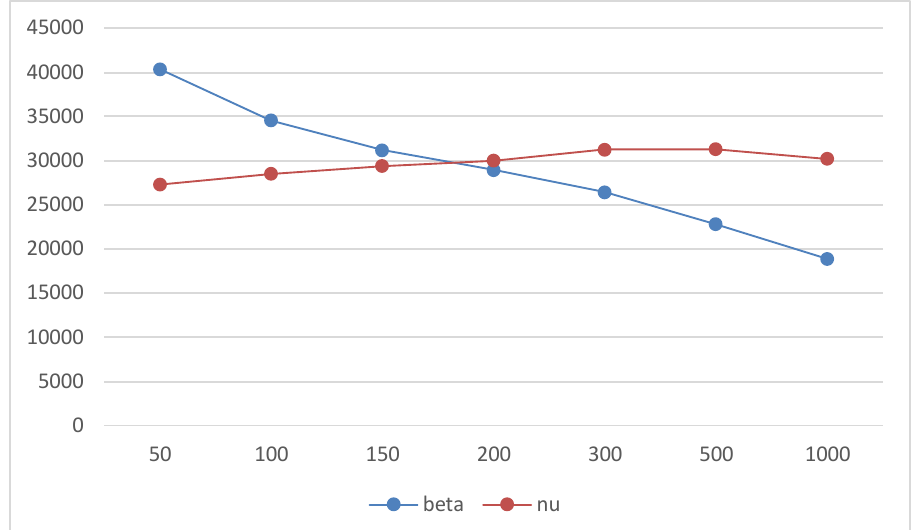
Fig. 6. Values of P under alteration of β and υ for decentralized scenario.